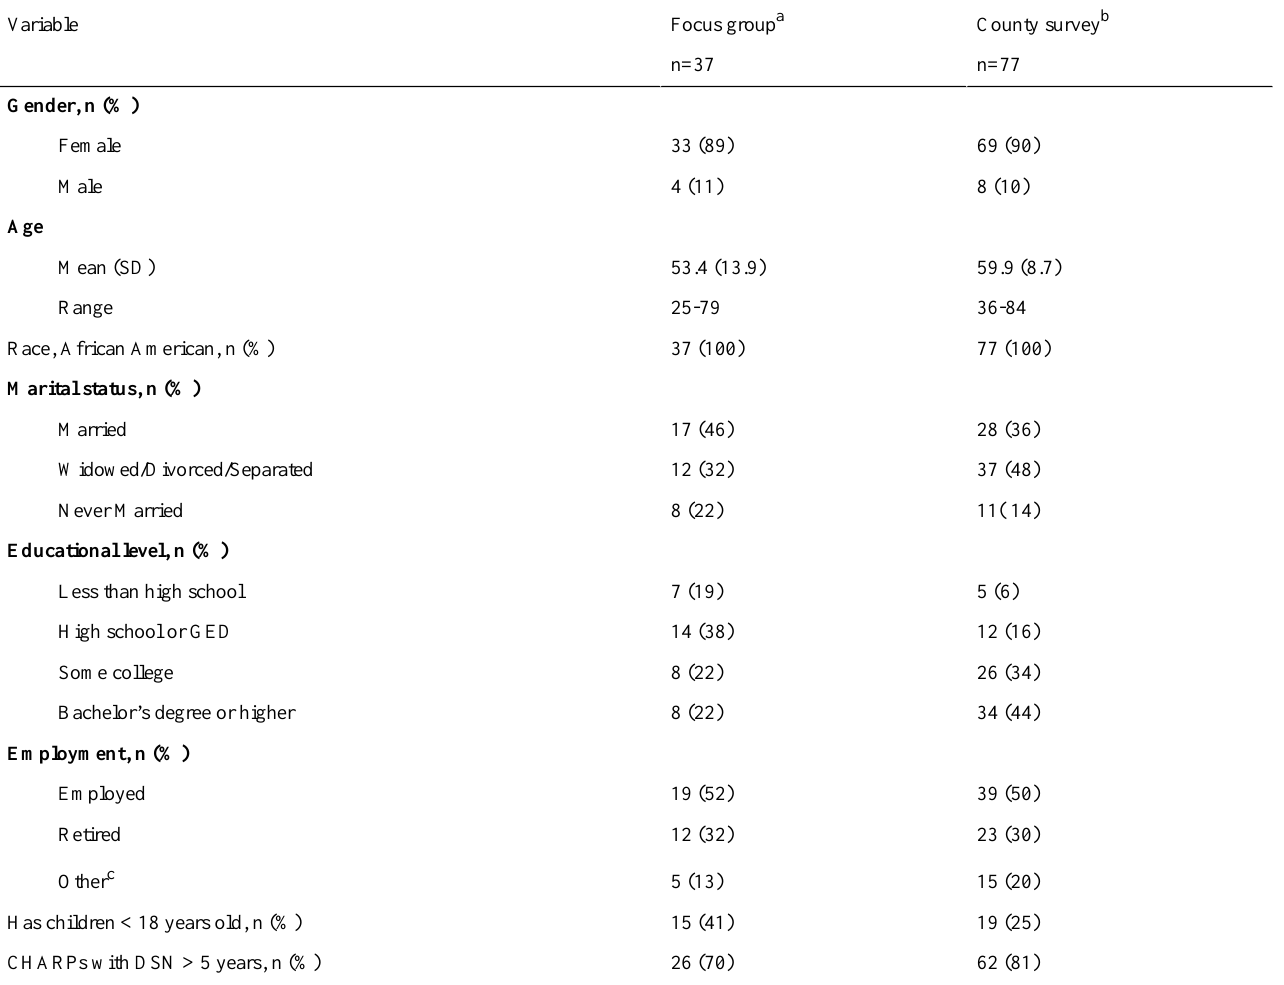
Table 1. Focus group and county survey participants’demographic